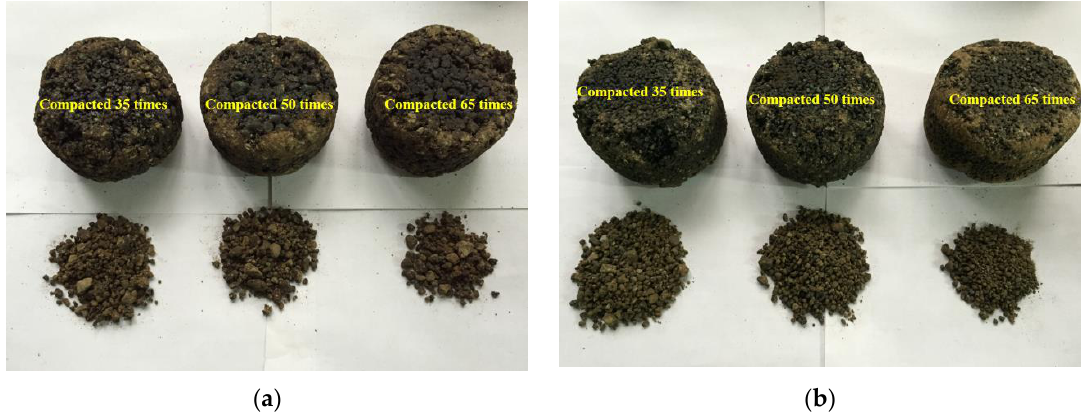
Figure 6. Cantabro loss of Marshall samples with different number of blows (150 °C): ( a ) PAC-1-I; ( b ) PAC-1-II.